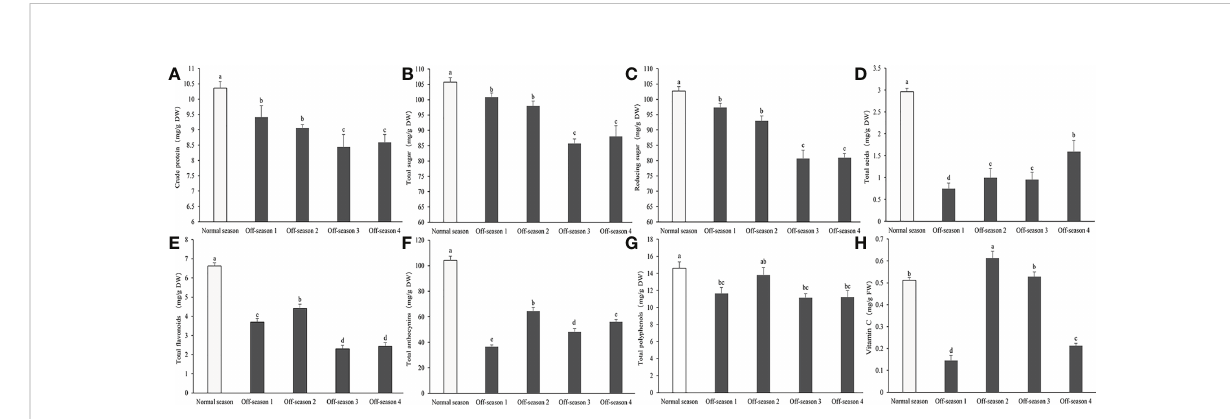
FIGURE 5 Contents of main nutritional composition in differential groups ’ mulberry fruits. (A) Crude protein, (B) total sugar, (C) reducing sugar, (D) total acids, (E) total fl avonoids, (F) total anthocyanins, (G) total polyphenols, (H) vitamin (C) Within a panel, bars labeled with different lowercase letters differ signi fi cantly ( P<